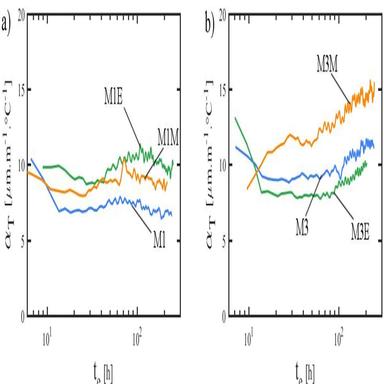
Coefficient of thermal expansion versus equivalent time for a) CEMI-based mortars and b) CEMIII/A-based mortars.